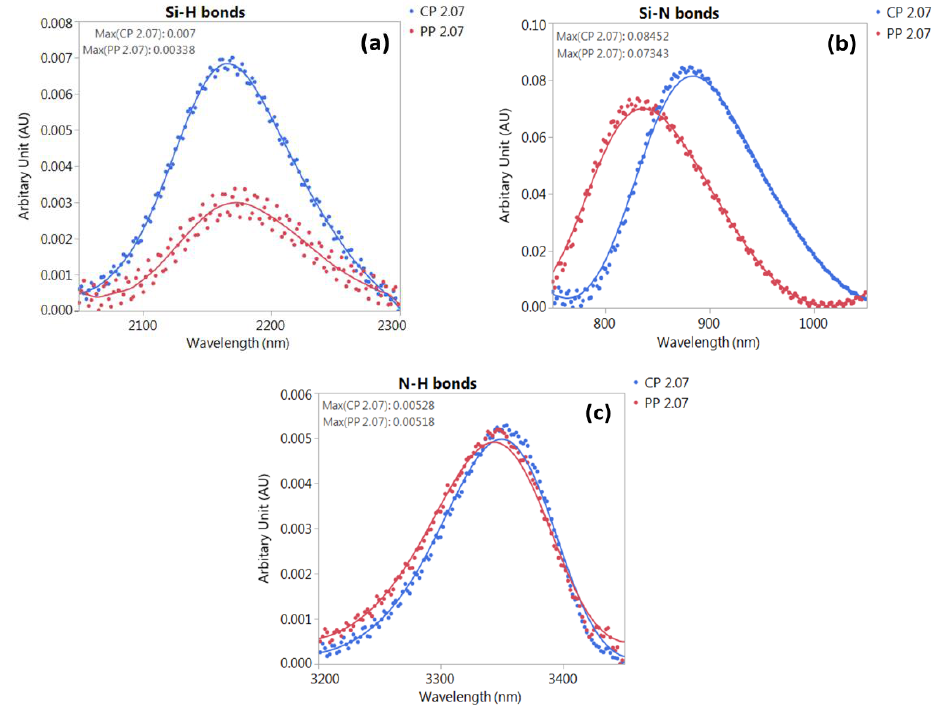
Figure 5. IR absorbance of ( a ) Si–H, ( b ) Si–N, and ( c ) N–H bonds by Fourier transform infrared (FTIR) characterizations for the SiN x films deposited by the CP and PP methods. The smooth curves are provided as a guide to the eye for indicating the absorbance peaks.